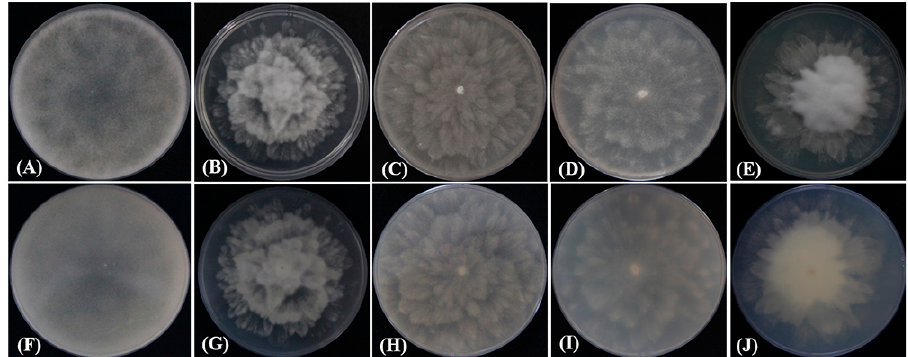
Figure 3. Colony formation of strain ZS01 isolated from camphor cultured after 3 days on different media at 25 °C. ( A ) Top and ( F ) reverse views of colony morphology on CMA medium. ( B ) Top and ( G ) reverse views of colony morphology on PDA medium. ( C ) Top and ( H ) reverse views of colony morphology on V8–agar medium. ( D ) Top and ( I ) reverse views of colony morphology on PCA medium. ( E ) Top and ( J ) reverse views of colony morphology on GPYA medium.